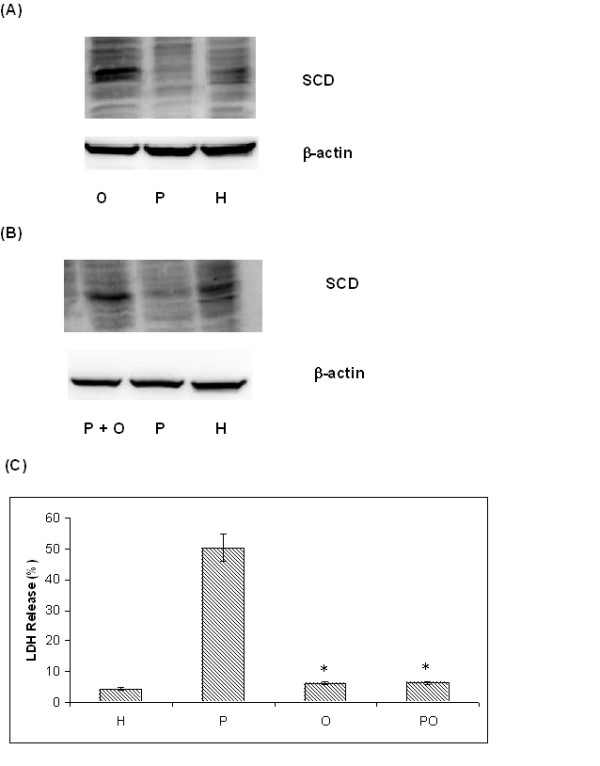
Effect of palmitate on stearoyl-CoA desaturase (SCD) measured by western blotting. (A) SCD was downregulated in the palmitate (0.7 mM) cultures as compared to the oleate (0.7 mM) and control cultures. (B) Co-supplementation of oleate (0.3 mM) with palmitate (0.4 mM) prevented the downregulation of SCD. (C) Co-supplementing palmitate (0.4 mM) with oleate (0.3 mM) decreased LDH release significantly, P < 0.01 (t-test). P: treated with 0.7 mM palmitate for 48 hours, PO: treated with 0.4 mM palmitate plus 0.3 mM oleate for 48 hours. Data expressed as average +/- SD from three independent experiments, * significantly lower than palmitate, p < 0.01 by t-test.